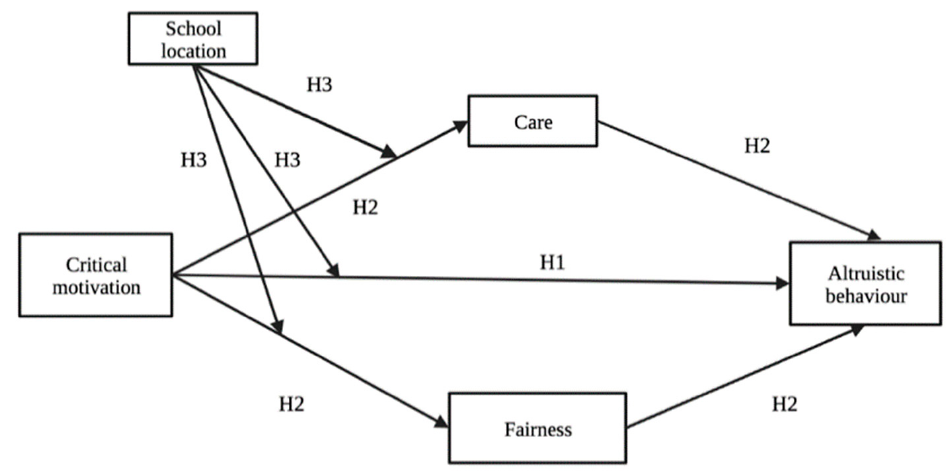
Figure 1. The Hypothesized Moderated Mediation Model.